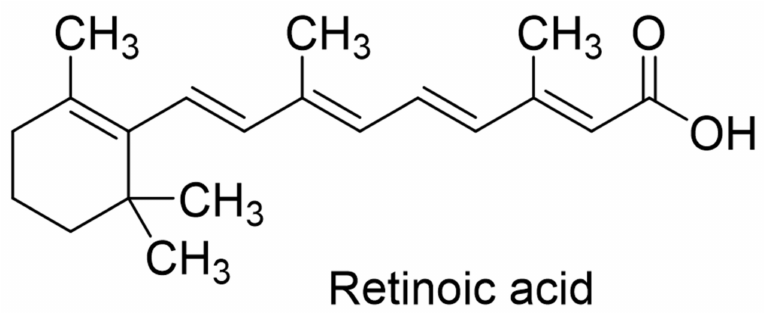
Figure 1. Chemical structure of retinoic